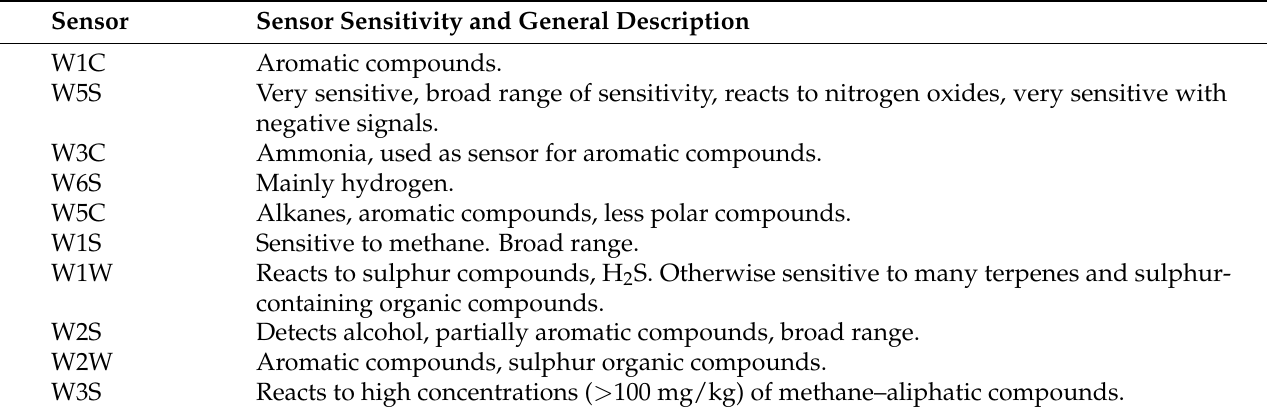
Table 1. Descriptions of the sensor array in PEN-3 e-nose.